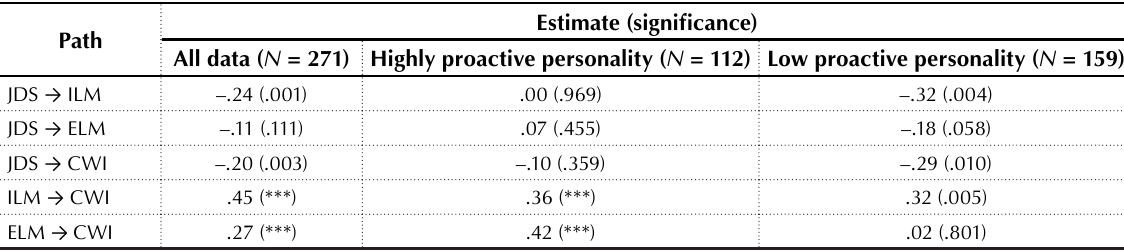
Table 4. Moderating effects of proactive personality